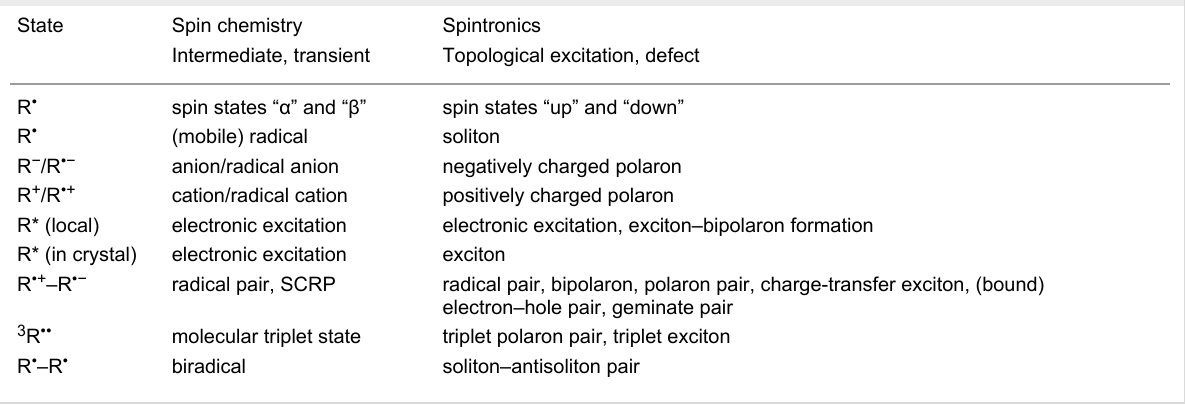
Table 1: Comparison of terminology and states in spin chemistry and spintronics.